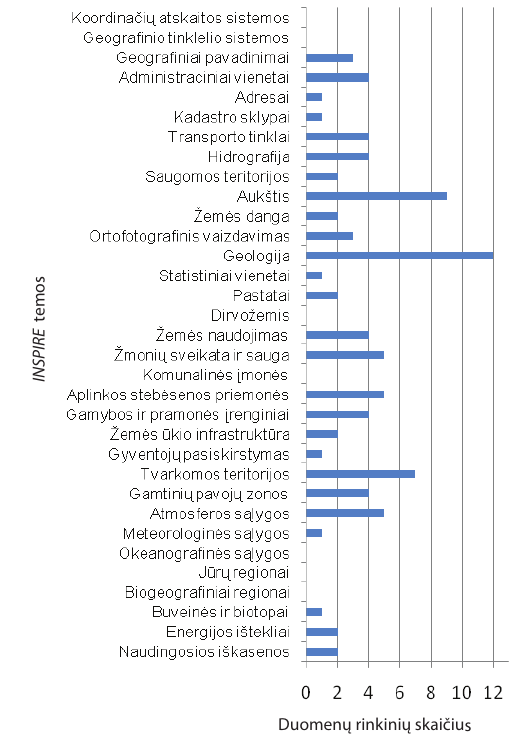
Fig. 5. Data on INSPIRE themes in Lithuania